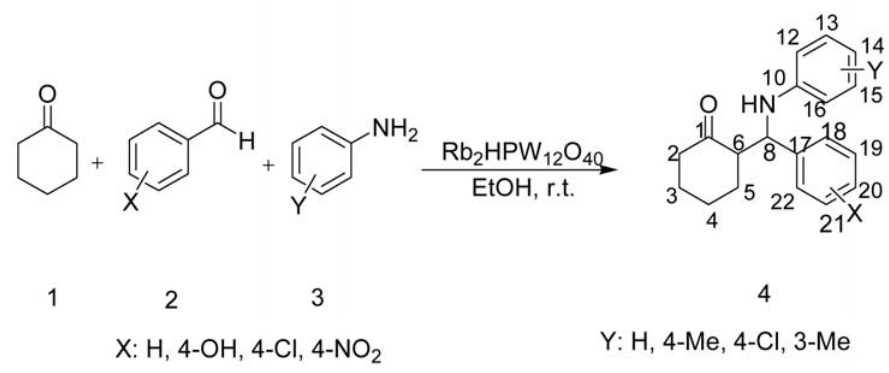
Table 1 . Optimization of the reaction conditions [ a ] Table 2. In all cases β -amino ketone derivatives were ob-